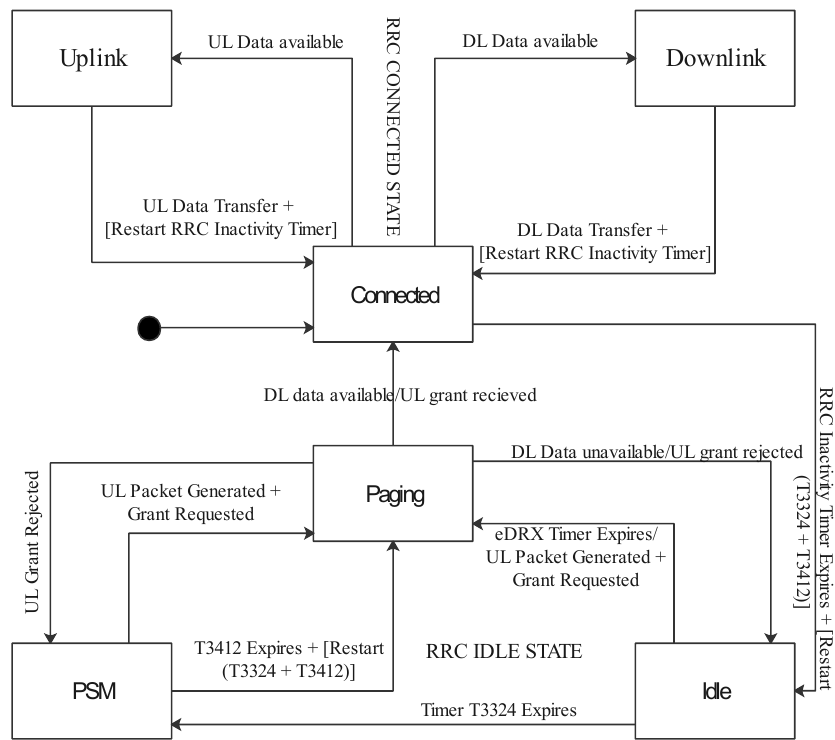
Figure 11. The PSM and eDRX